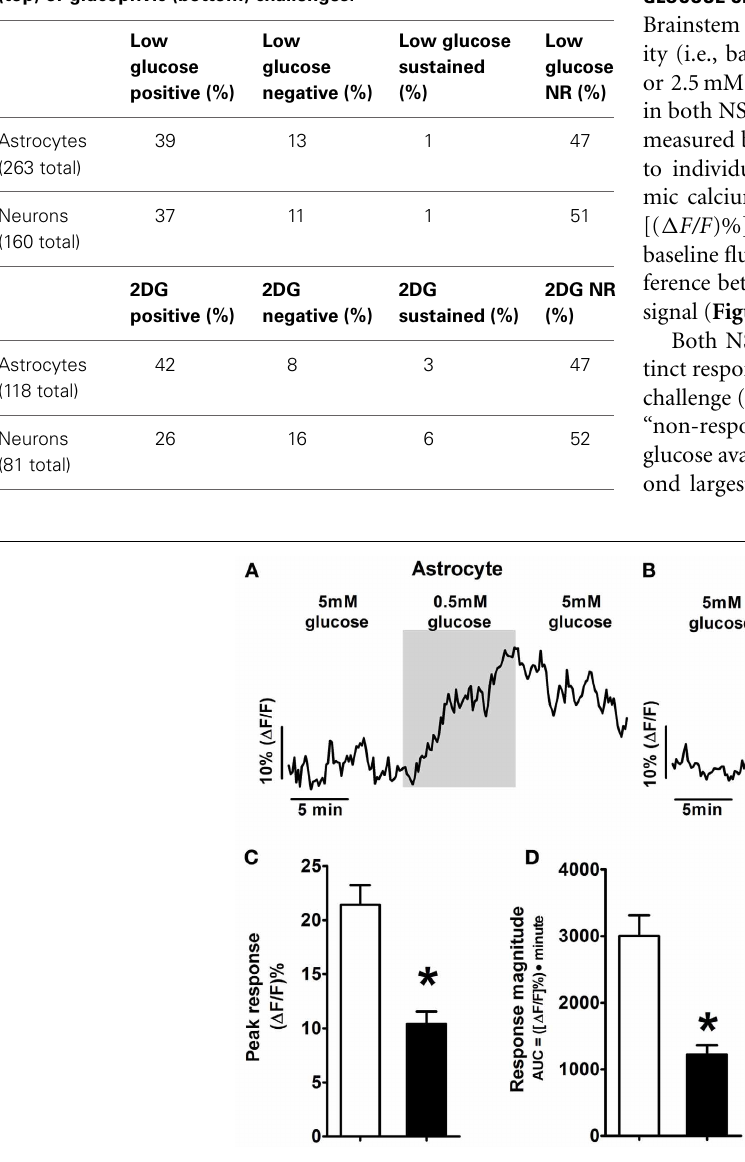
Table 1 | Classification of cellular response patterns to low glucose (top) or glucoprivic (bottom) challenges.